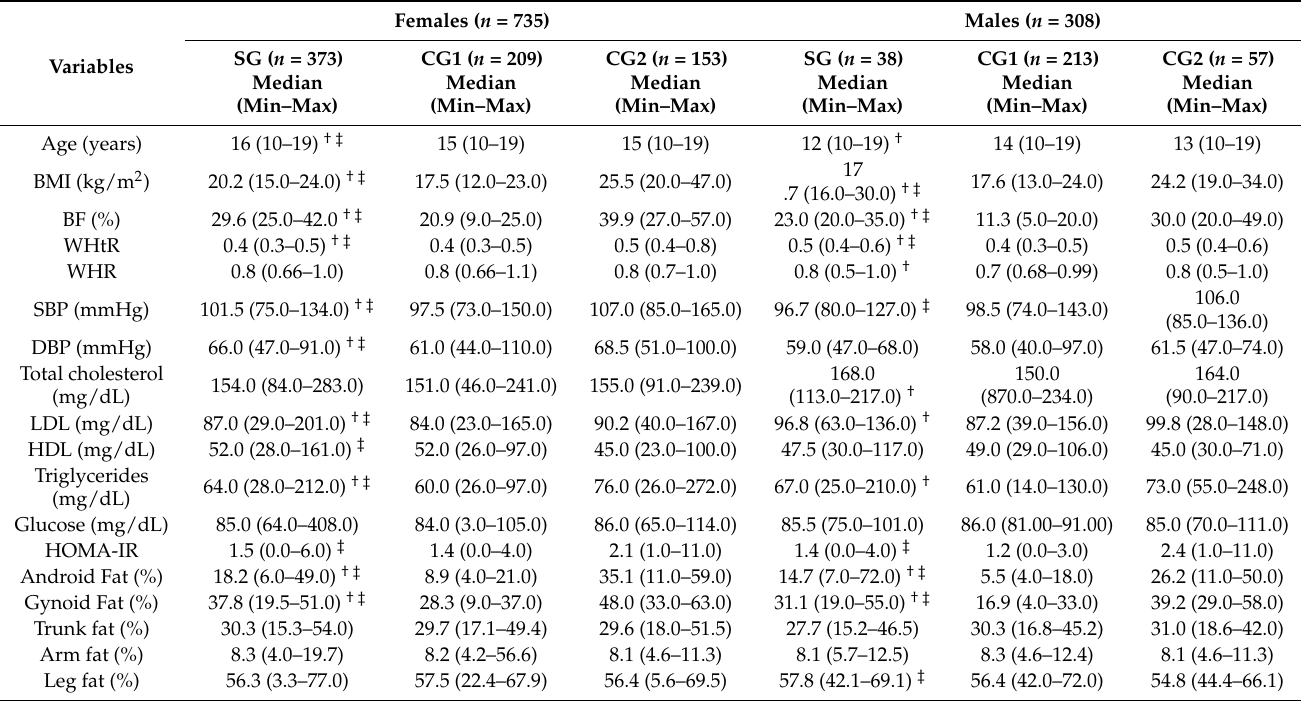
Table 1. Comparison of the study group with groups 1 and 2, according to sex. Viçosa-MG, Brazil, 2010 to 2015 ( n = 1043).